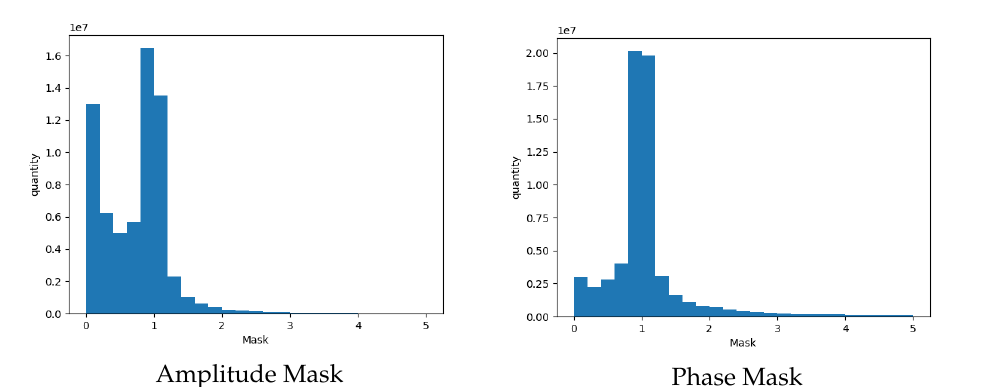
Figure 3. We randomly selected 1200 groups of speech and calculated the standard mask values of amplitude and phase. It is intuitively apparent that some mask values are outside the range of 0 to